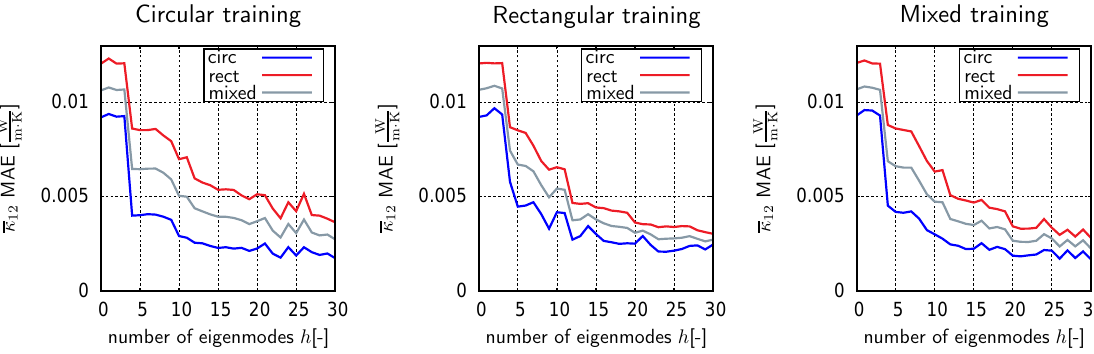
Figure 12. The mean absolute error (MAE) of κ 12 is given for each of the training types and test